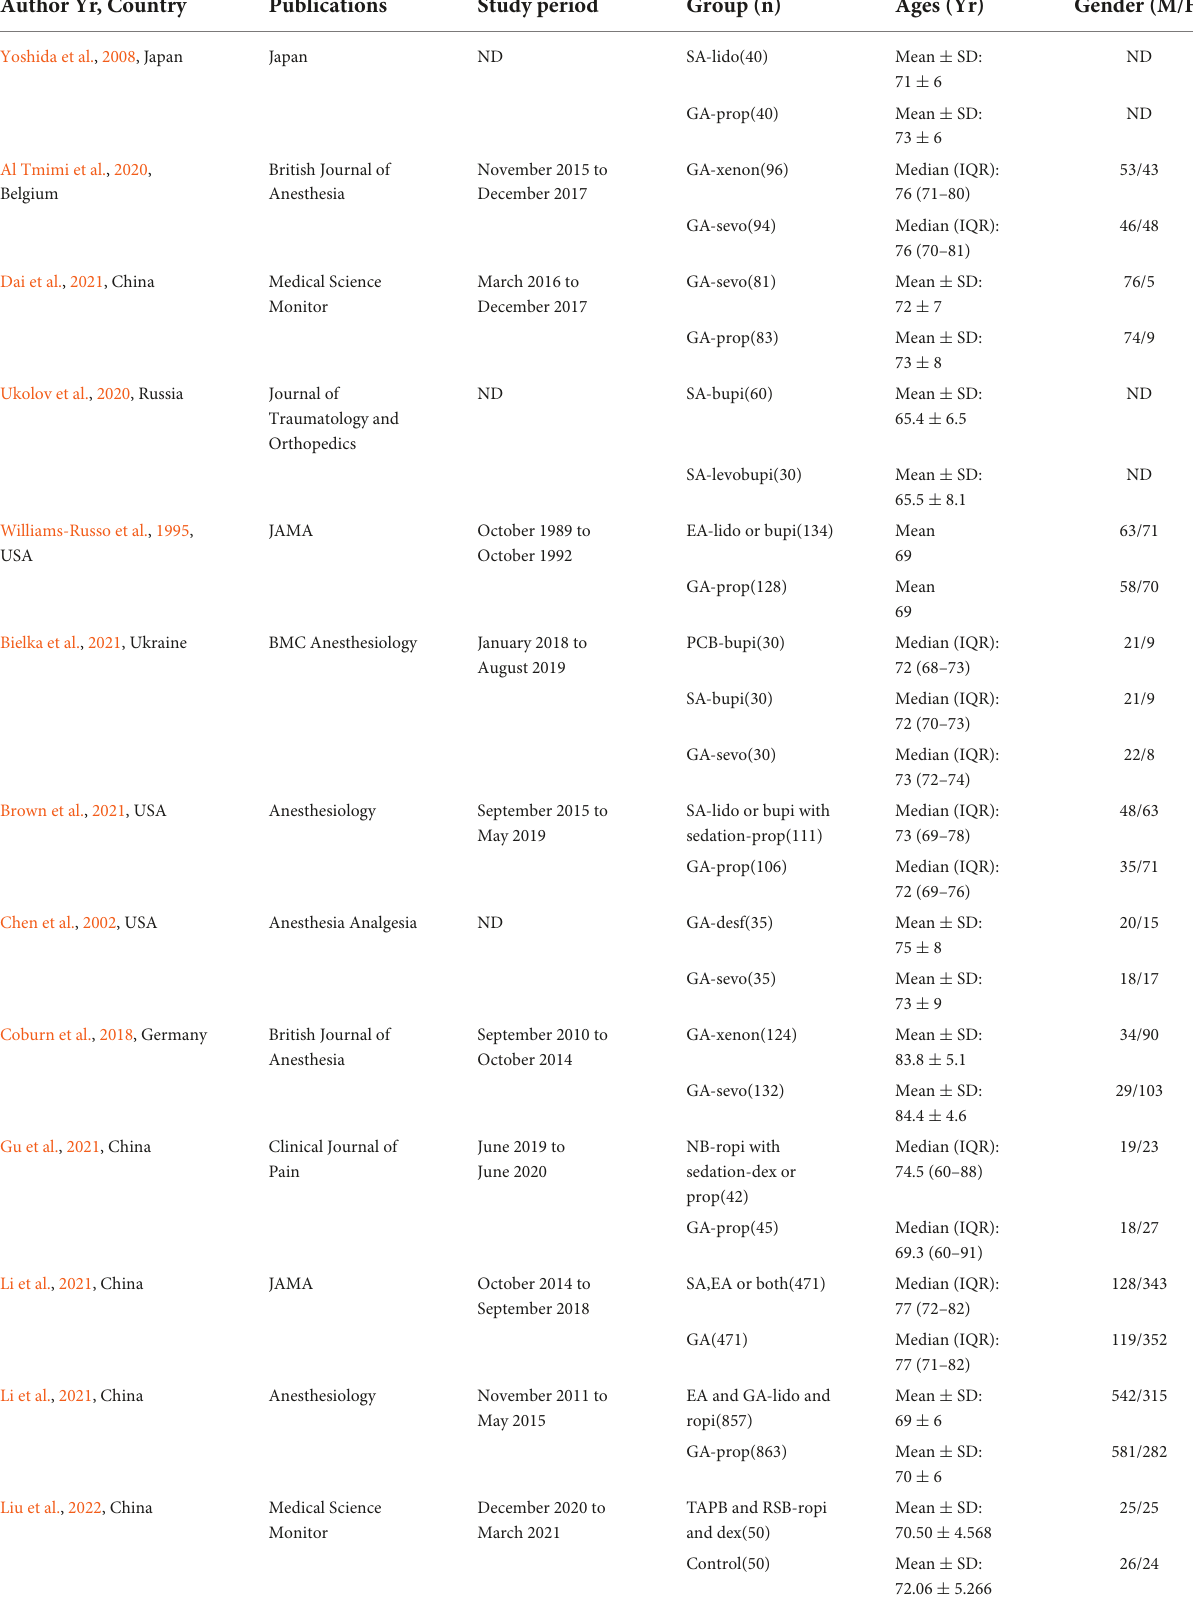
TABLE 2 Summary of the characteristics of patients in 19 eligible